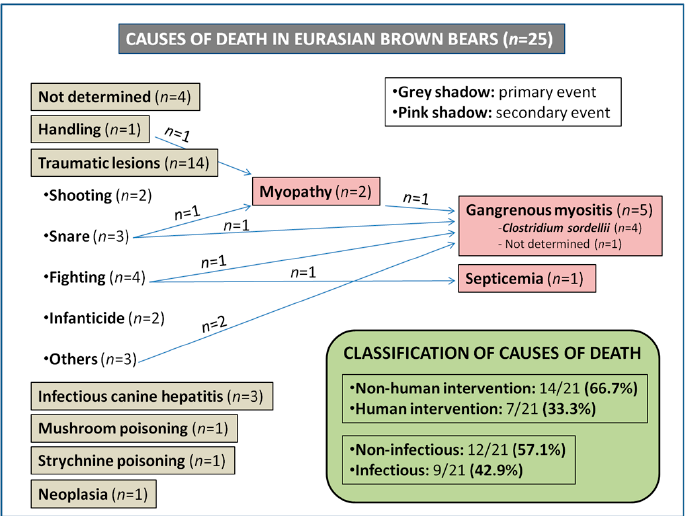
Figure 1. Mortality cases in Eurasian brown bears ( Ursus arctos arctos ) in Asturias and Castilla y León (northwestern Spain) from 1998 to 2018. Blue arrows indicate bears which died from a combination of human activities or non-human related trauma and secondary bacterial infection.